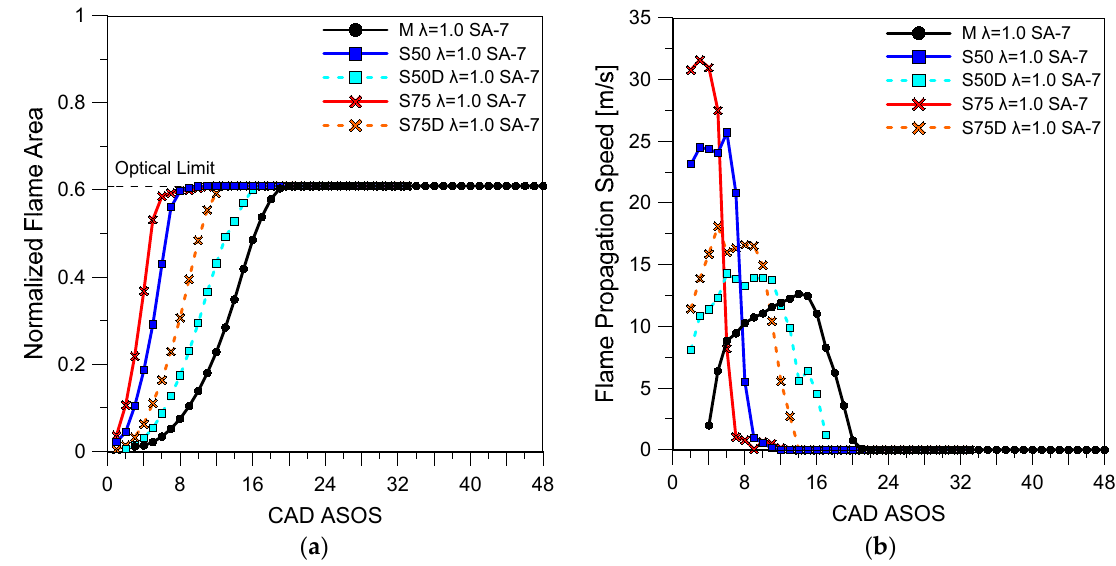
Figure 14. Average flame front evolution in terms of normalized area (cross-section piston area) and flame propagation speed for stoichiometric air-fuel ratio and five different fuels.